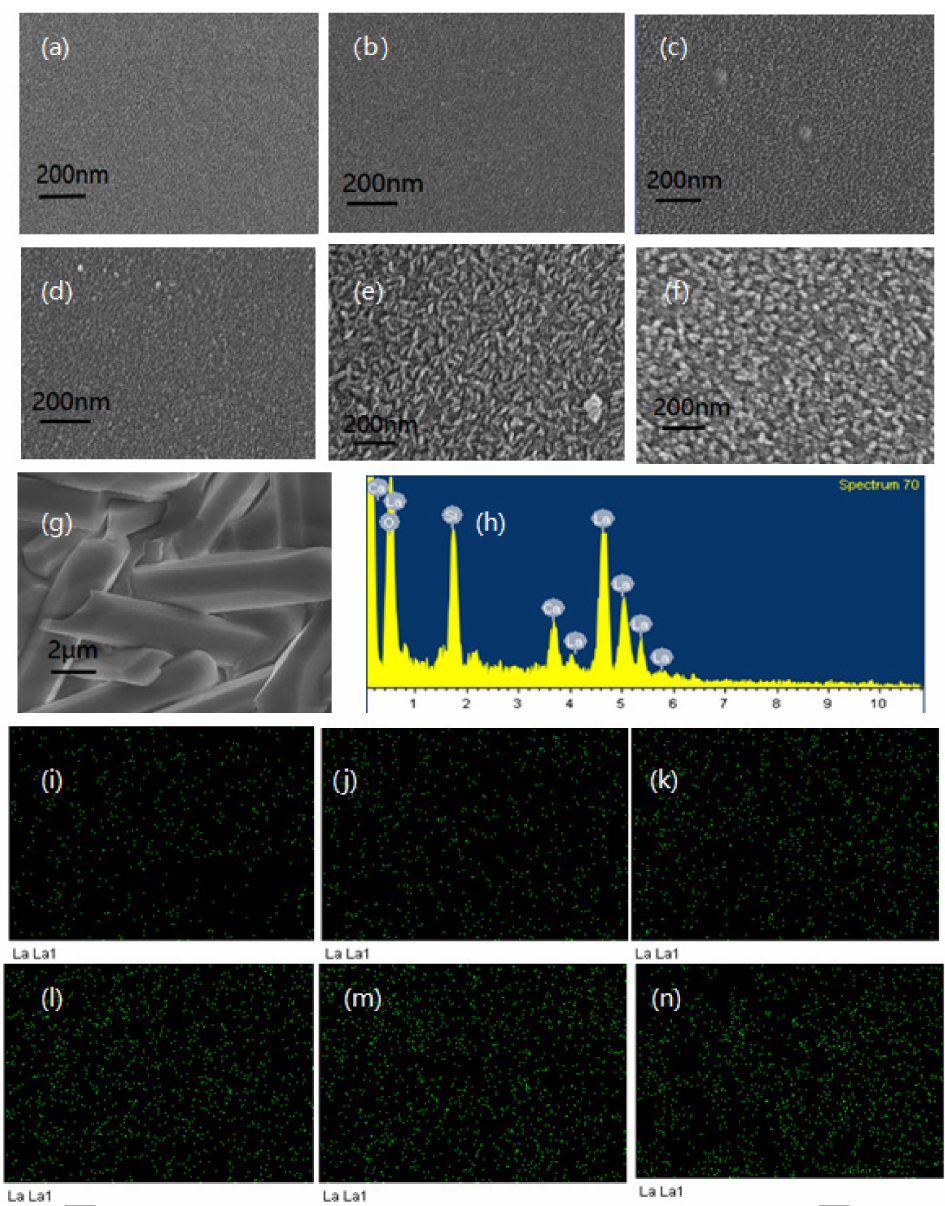
Figure 2. ( a – g ) SEM image of L0-L56. ( h ) EDX spectra under the ( g ) image region. ( i – n ) Elemental mapping of La from